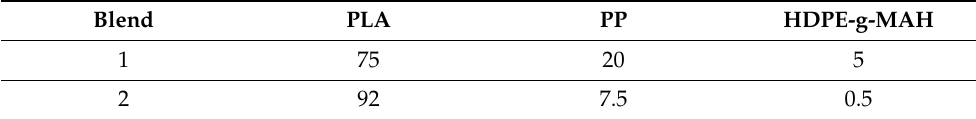
Table 1. Compositions prepared for ternary blend